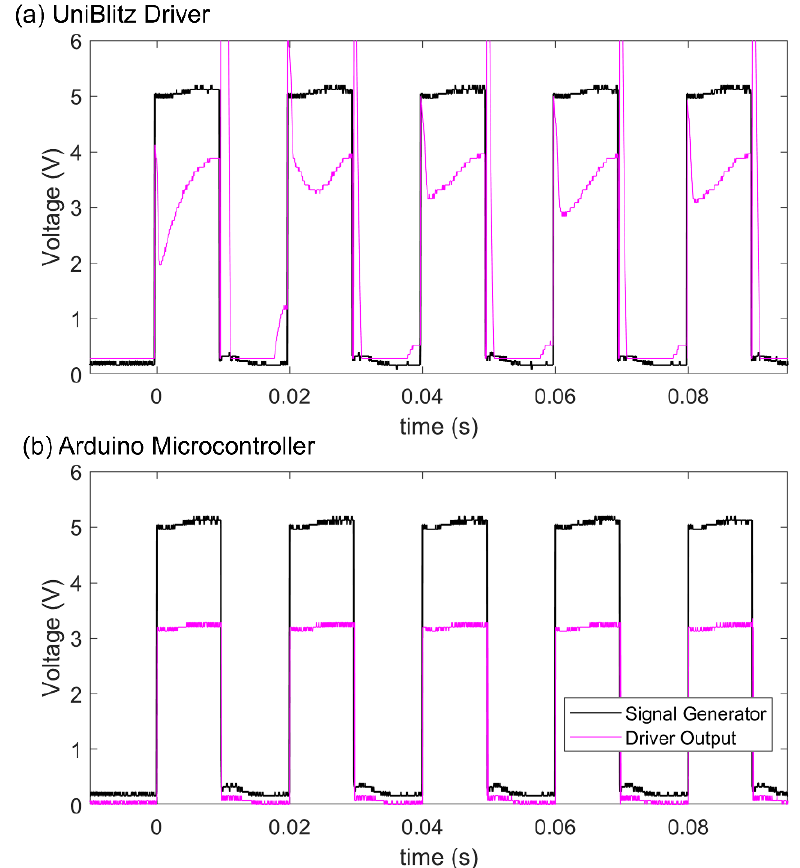
Figure 4. Simultaneous oscilloscope readings of the XPS controller signal and the: ( a ) Uniblitz driver output signal to the mechanical shutter, and ( b ) Arduino microcontroller output signal to the EOM and solenoid shutters.